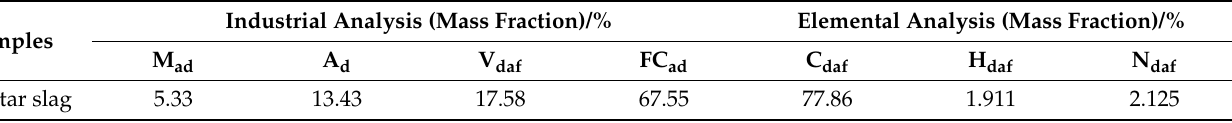
Table 1. Proximate and ultimate analyses of the coal tar residue samples. Industrial Analysis (Mass Fraction)/% Elemental Analysis (Mass Fraction)/% Samples Coal tar